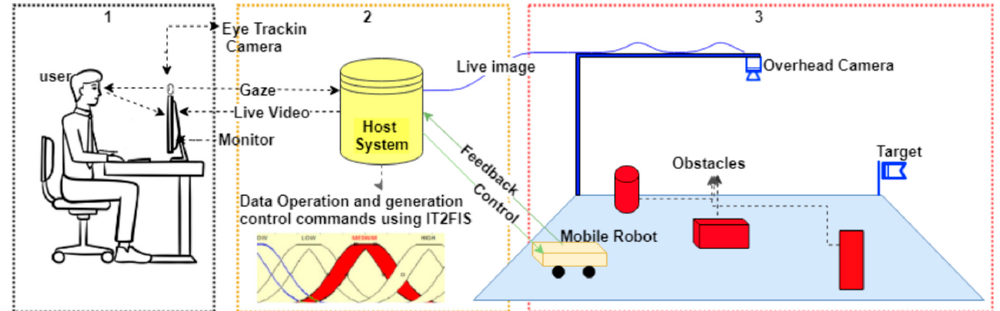
Figure 1. Interaction of the gaze-guided robot control system (1. User side, 2. Control system, 3. Robot side).